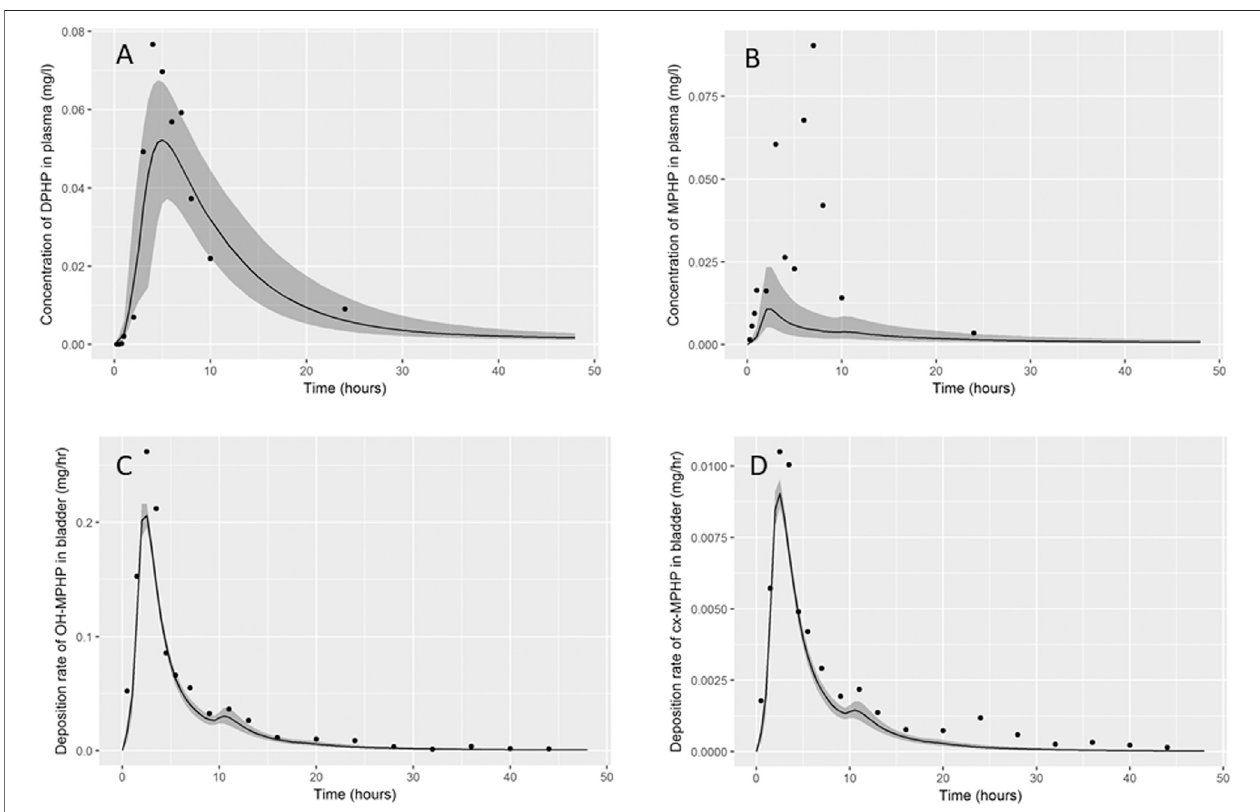
FIGURE8| Fitofthecalibratedmodeldata (A) bloodDPHP, (B) bloodMPHPandurinaryexcretionof (C) OH-MPHPand (D) _cx-MPHPforvolunteerDusingglobal (non-volunteer speci fi c) and local (volunteer speci fi c) parameters provided in Table 3 and Table 4 . The central estimates indicated in plots correspond to the posterior modewhereastheshadedregionsrepresent95%intervalsfortherespectivecurves.ThetrendsforvolunteerDwerebroadlyrepresentativeofvolunteersBandFwhose data are not shown.